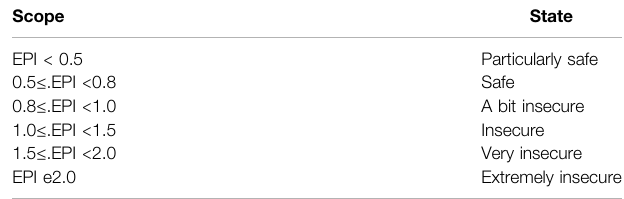
TABLE 3 | Classi fi cation of